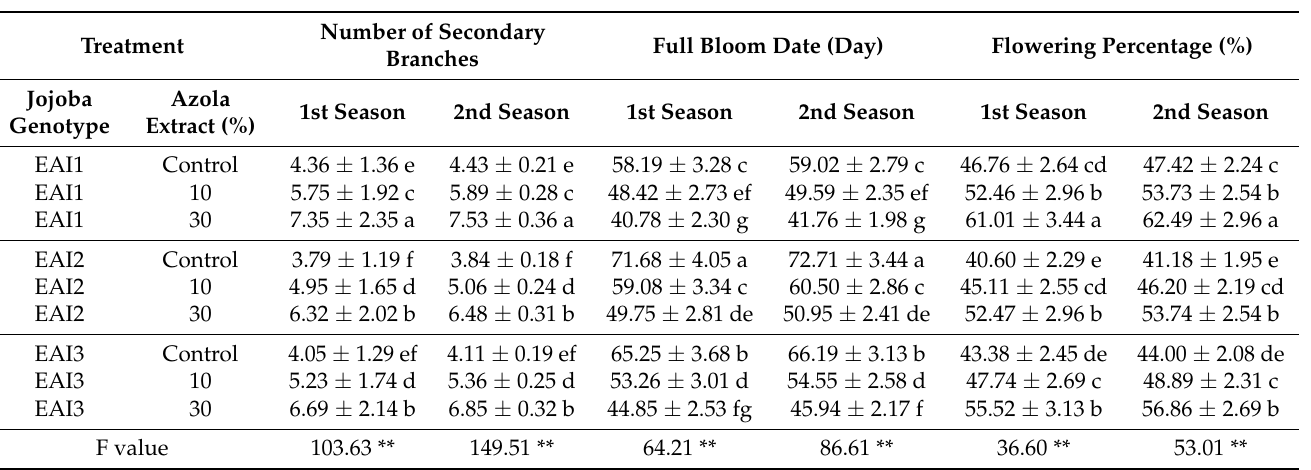
same column. Table 2. In both seasons of the study, the mean values of the number of secondary branches, full bloom date (day), and flowering percentage (%) of jojoba shrubs as influenced by combined treatments of plant genotypes and foliar application of Azolla filiculoides Lam. plant